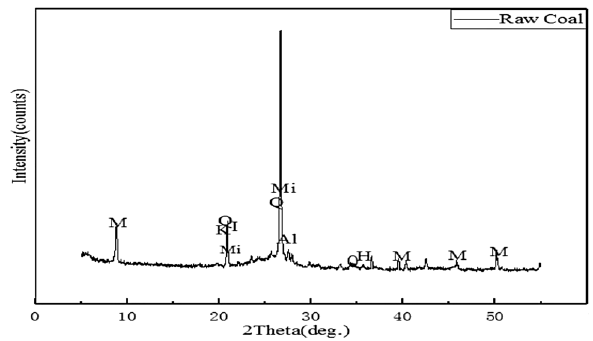
Fig. 2 XRD spectrum of raw stone coal. The minerals identified are: H hematite, I illite, K kaolinite, M muscovite, Mi microcline, Q quartz, Al